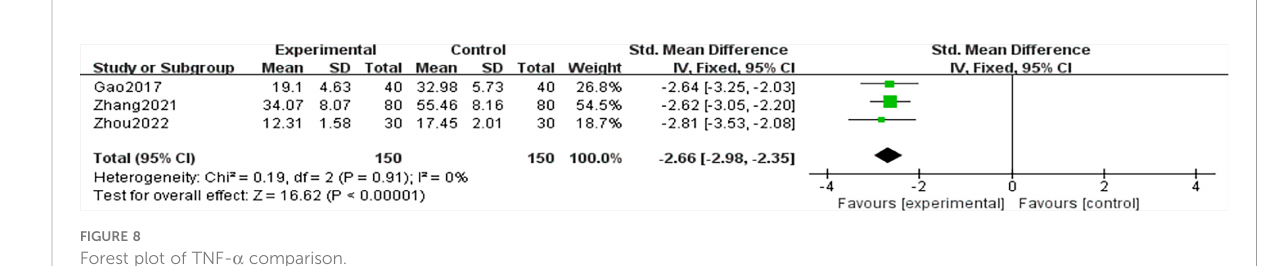
FIGURE 8 Forest plot of TNF- a comparison.